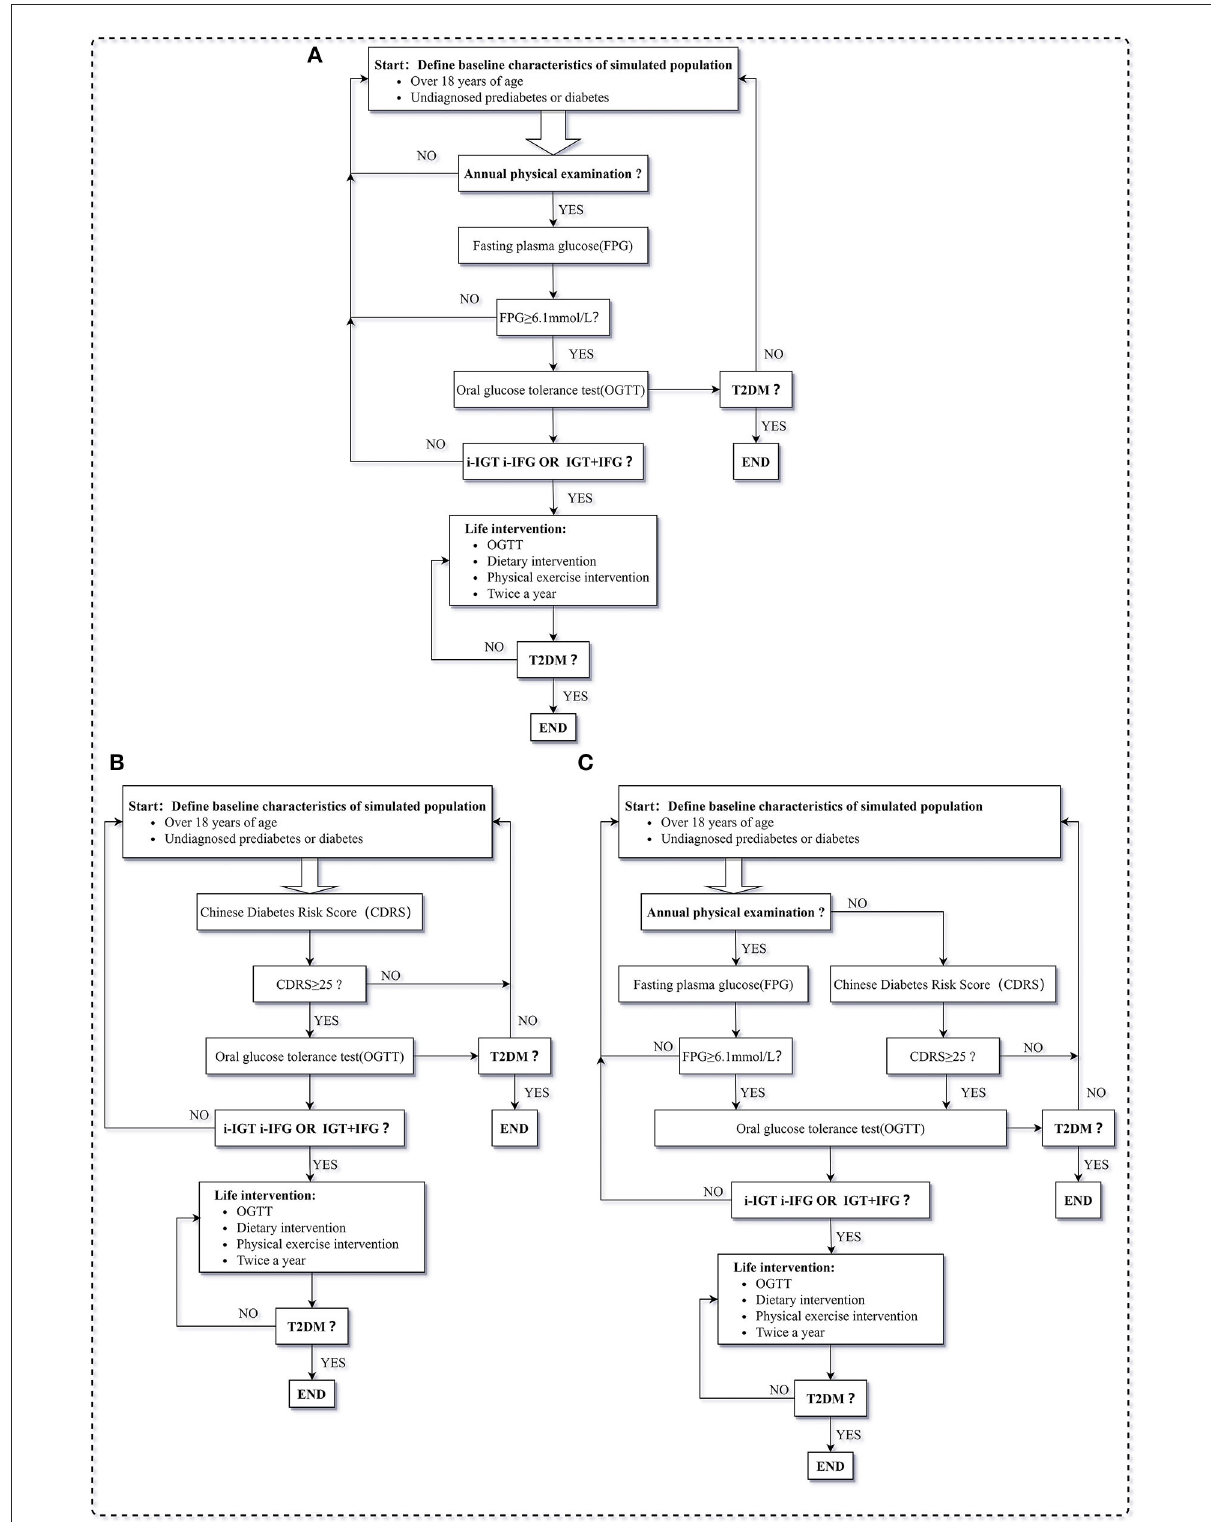
FIGURE1 Description of steps to pre-DM screening strategies, (A) is screening strategy of control group, (B) is screening strategy of screening strategy 1, (C) is screening strategy of screening strategy 2. T2DM, type 2 diabetes mellitus; FPG, fasting glucose test; I-IFG, isolated impaired fasting glucose; I-IGT, isolated impaired glucose tolerance; IFG + IGT, impaired fasting glucose and impaired glucose tolerance; NGT, normal glucose tolerance; OGTT, oral glucose tolerance test; Pre-DM, pre-diabetes mellitus; CDRS, Chinese Diabetes Risk